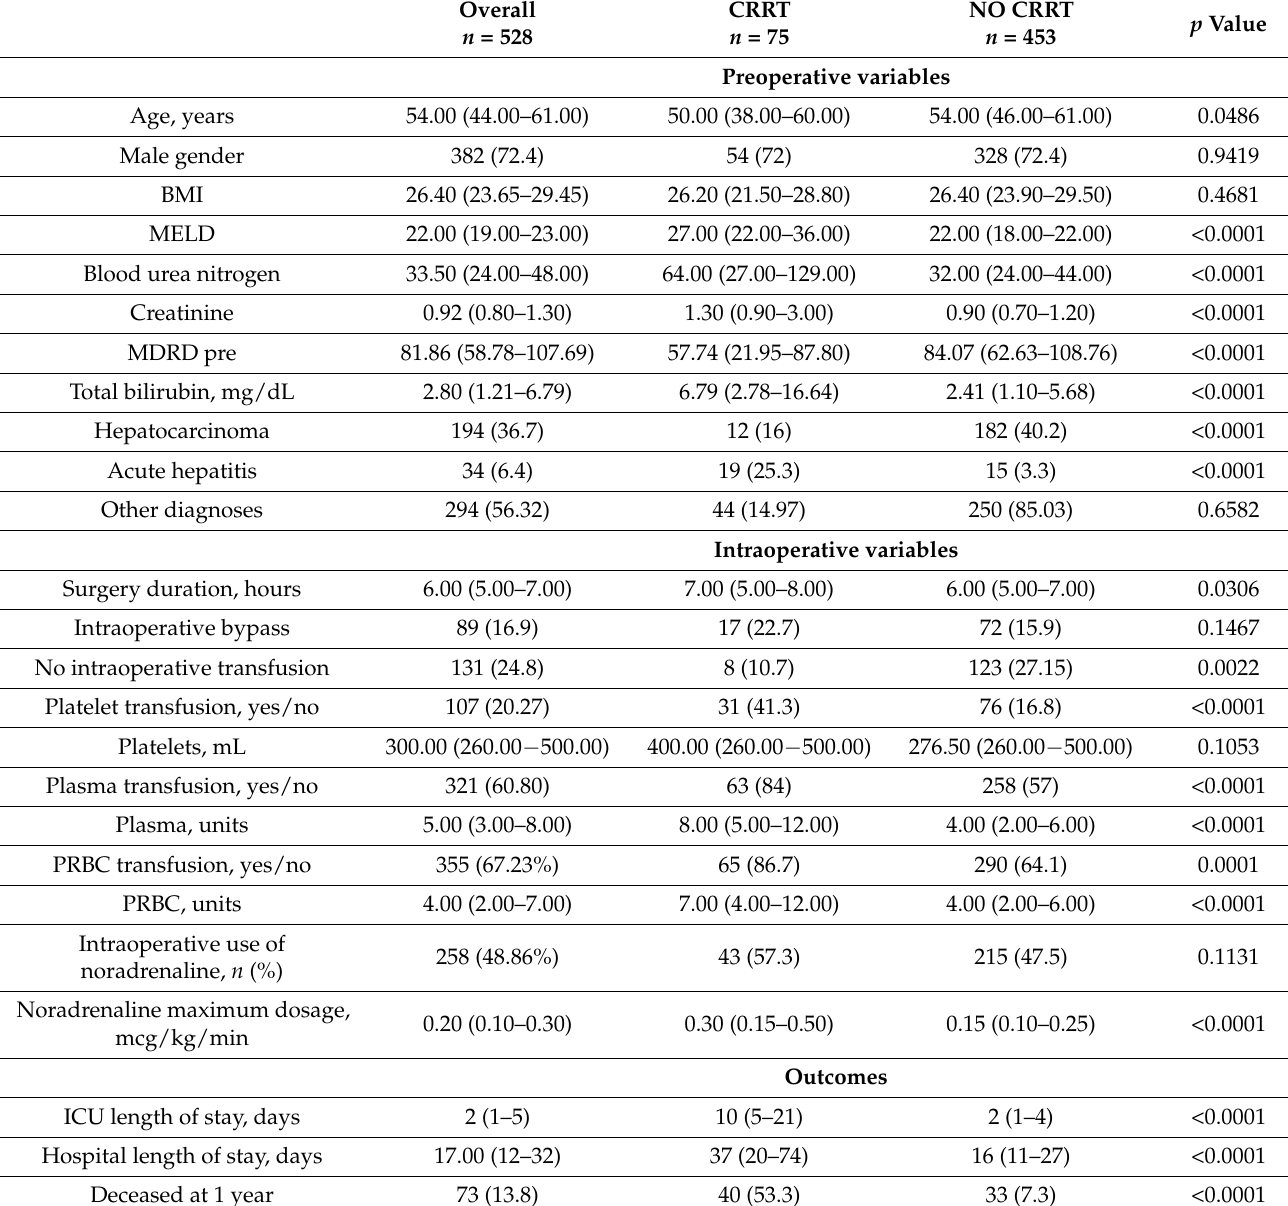
Table 1. Comparison of the preoperative and intraoperative characteristics of the two study groups: patients treated with CRRT or without CRRT in the first week after OLT. Preoperative and intraop- erative variables, as well as outcomes, are shown. BMI: Body mass index; CRRT: continuous renal replacement therapy; MELD: Model for End-stage Liver Disease; MDRD: Modification of Diet in Renal Disease; PRBC: packed red blood cells; ICU: intensive care